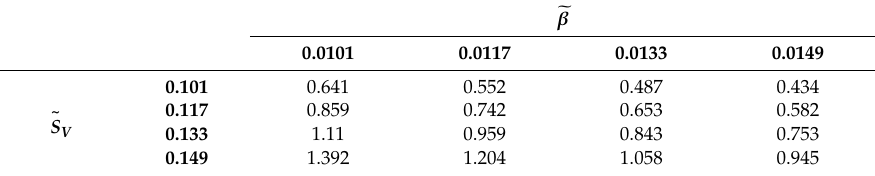
Table 3. Values of the UAE RBF for the selected values of parameters (cid:101) S V and (cid:101) β .